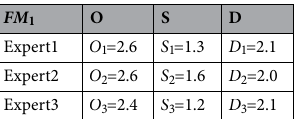
Table 4. The comprehensive value of risk factors of FM 1 .